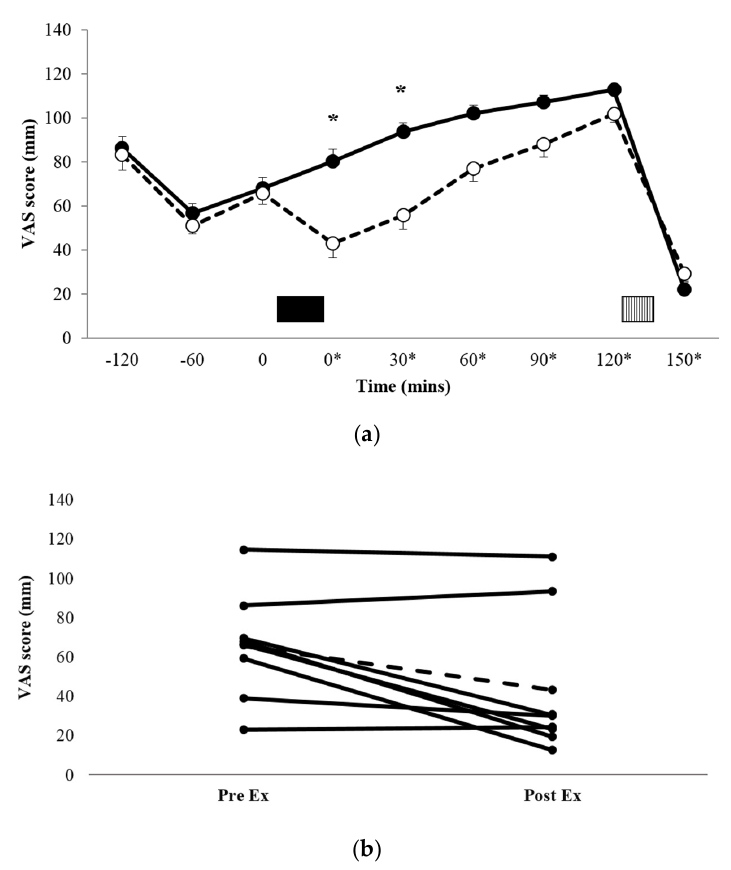
, dashed line). Solid block (cid:35)